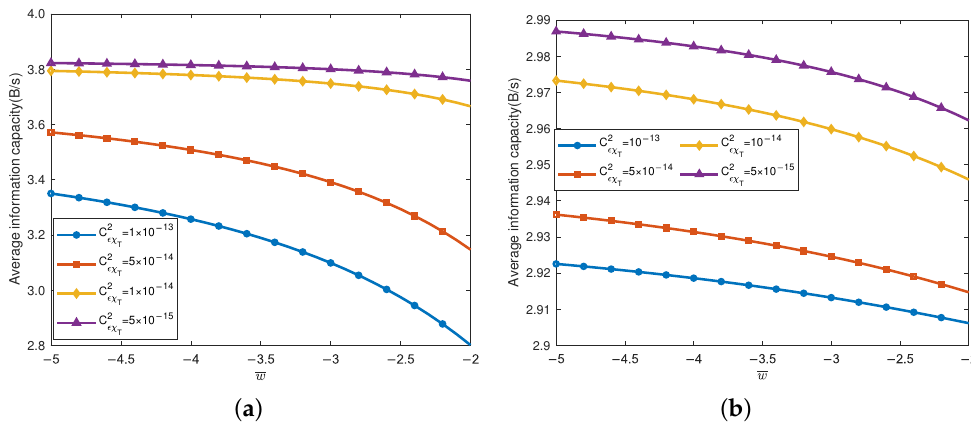
Figure 10. The capacity of the POV carrier link versus the ratio of temperature and salinity fluctuation contributions to the refractive index spectrum for the structural constant of the salinity-temperature = 5 × 10 − 15 , C 2 = 10 − 14 , C 2 = 5 × 10 − 14 , C 2 = 10 − 13 under ( a ) 4-QAM, fluctuation C 2 (cid:101)χ (cid:101)χ T (cid:101)χ T (cid:101)χ T T z = 100 m, ( b ) 256-QAM, z = 150 m.